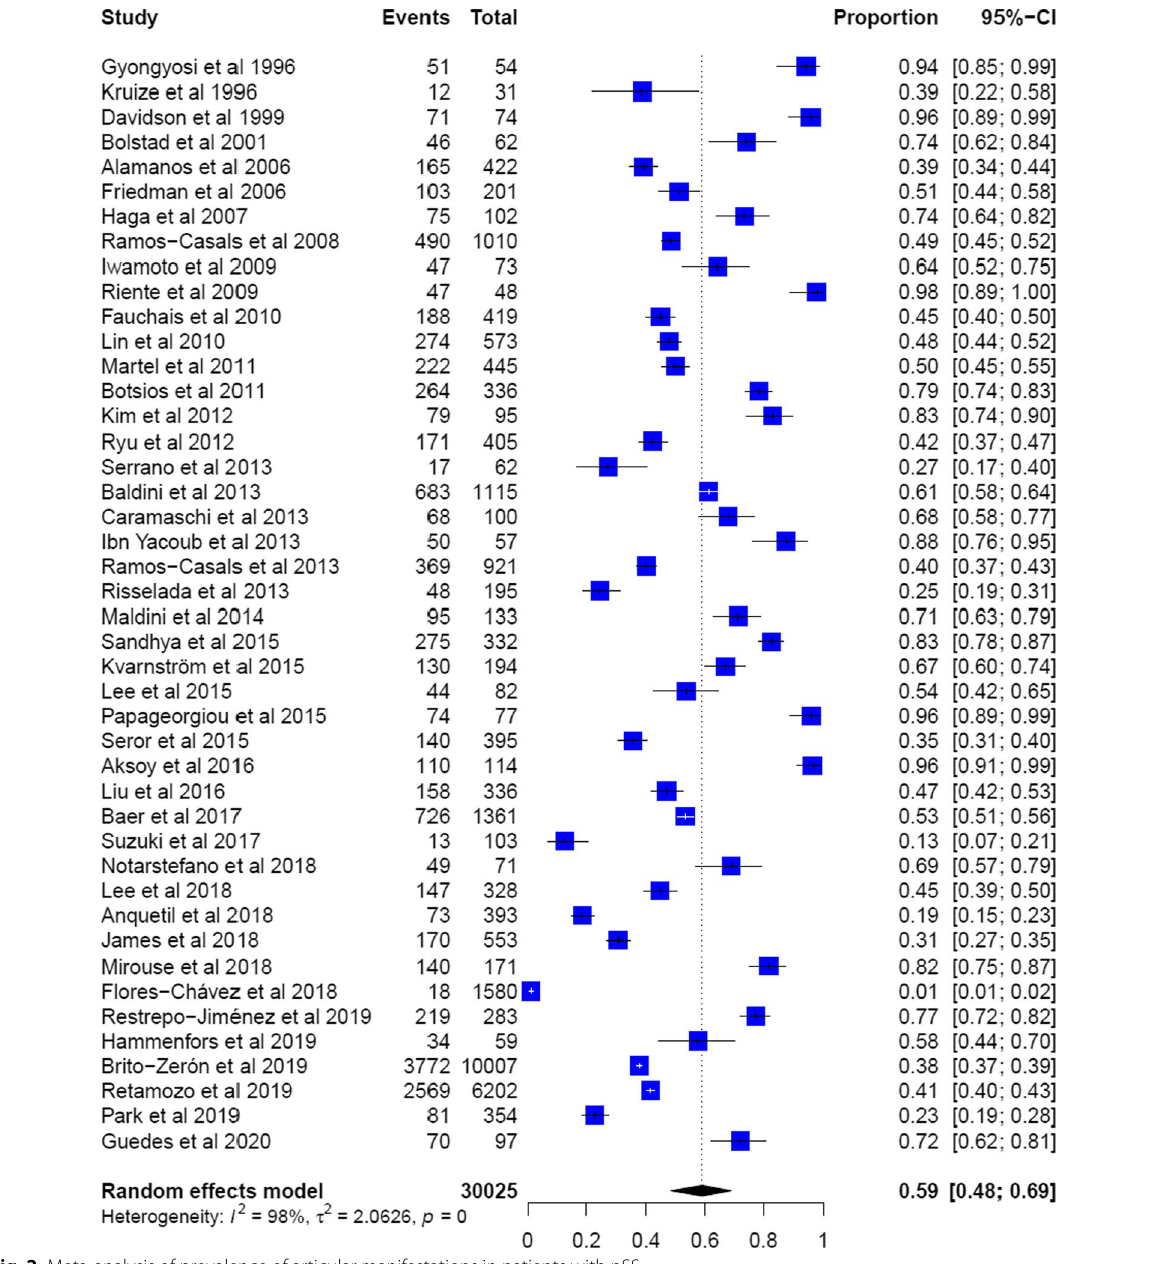
Fig. 2 Meta‑analysis of prevalence of articular manifestations in patients with